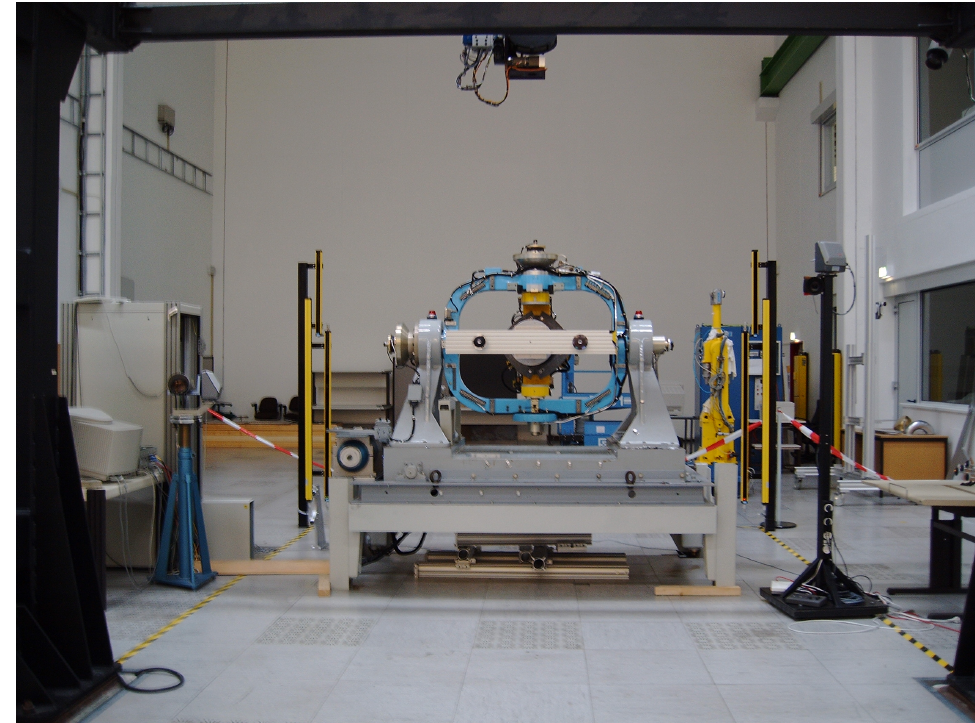
Figure 2. EPOS 1.0 target